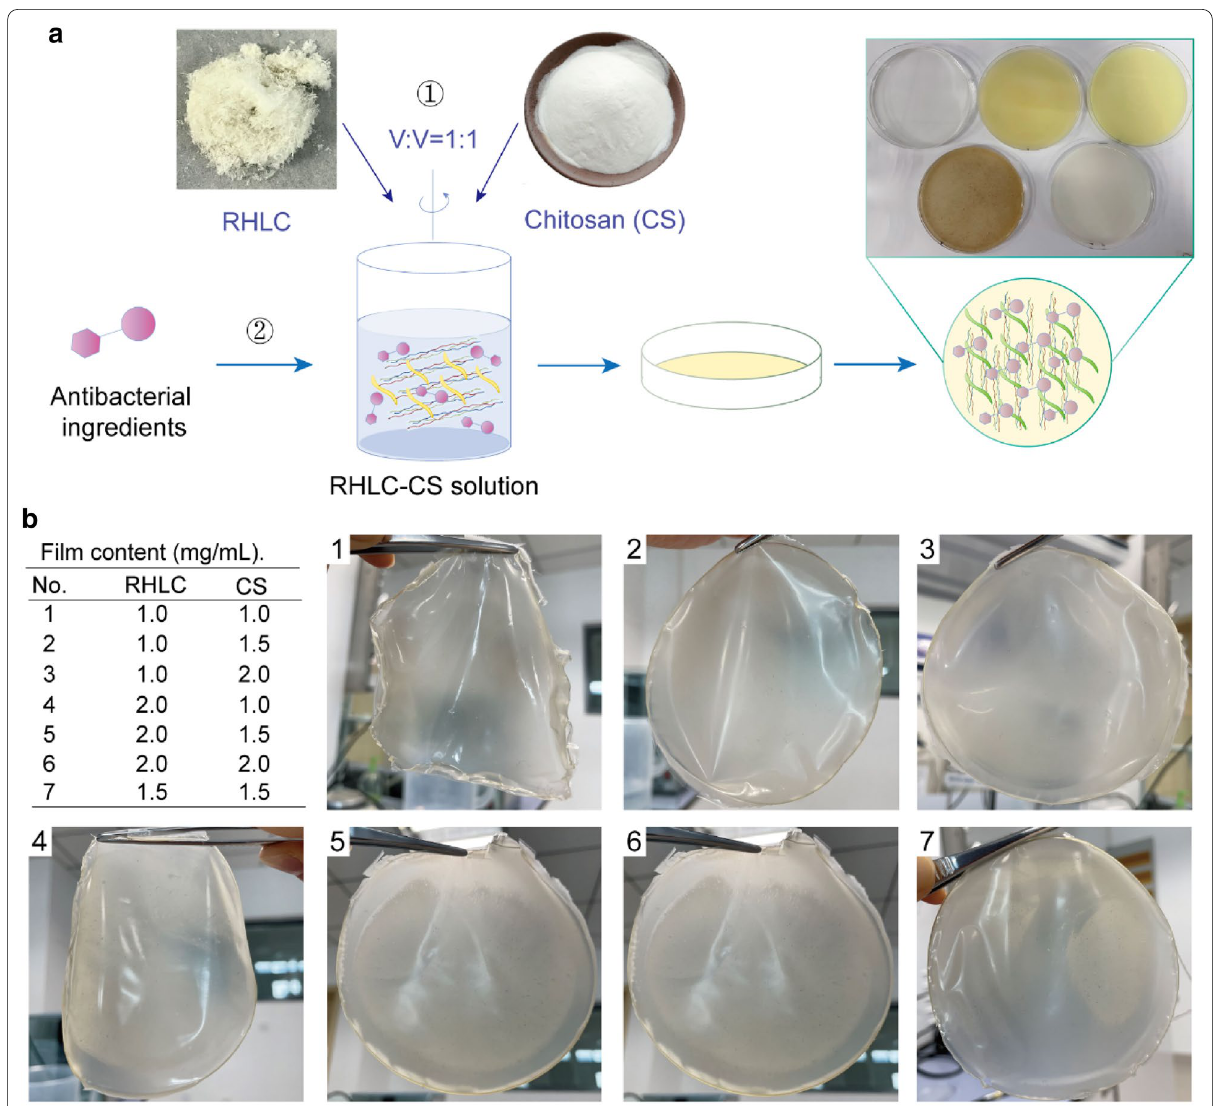
Fig. 5 Film-forming ability of RHLC with chitosan. a Preparation process of RHLC–chitosan film and additional adding of antibacterial ingredients. b Different concentrations and state of RHLC–chitosan (CS)